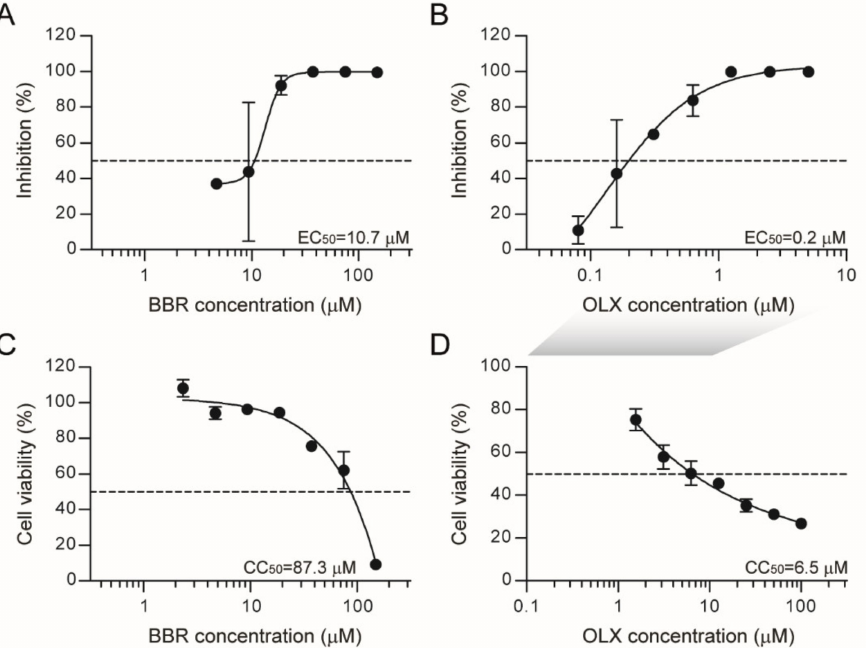
Figure 6. Berberine and obatoclax inhibit SARS-CoV-2 replication in primary nasal epithelial cells. Primary nasal epithelial cells cultured on an air-liquid interface were infected with SARS-CoV-2 (BavPat1 isolate) at an MOI of 10 in the presence of the indicated concentrations of ( A ) berberine (BBR) or ( B ) obatoclax (OLX) in a two-fold dilution series or 0.1% DMSO as a control. Viral RNA from duplicate apical surface supernatants at 72 hpi was quantified by qRT-PCR and plotted as percentage inhibition compared to the DMSO control. Error bars indicate SD (n = 2). Dashed line indicates 50% inhibition. Primary nasal epithelial cells cultured on an air-liquid interface were treated with the indicated concentrations of ( C ) BBR or ( D ) OLX or 0.1% DMSO. At 72 h, the ATP content in cells from duplicate samples was measured as a measure of cell viability, plotted as a percentage of the DMSO control. Error bars indicate SD. Dashed lines indicate 50% viability. A representative of two independent experiments is shown. The shaded grey box indicates that different OLX concentrations were used for antiviral (B) and viability assays